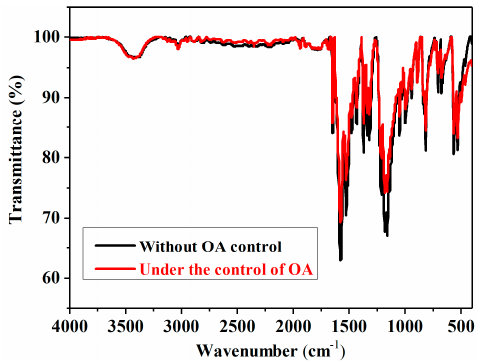
Figure 3. Typical MIR spectra of the DAST single crystals grown with and without the OA control.